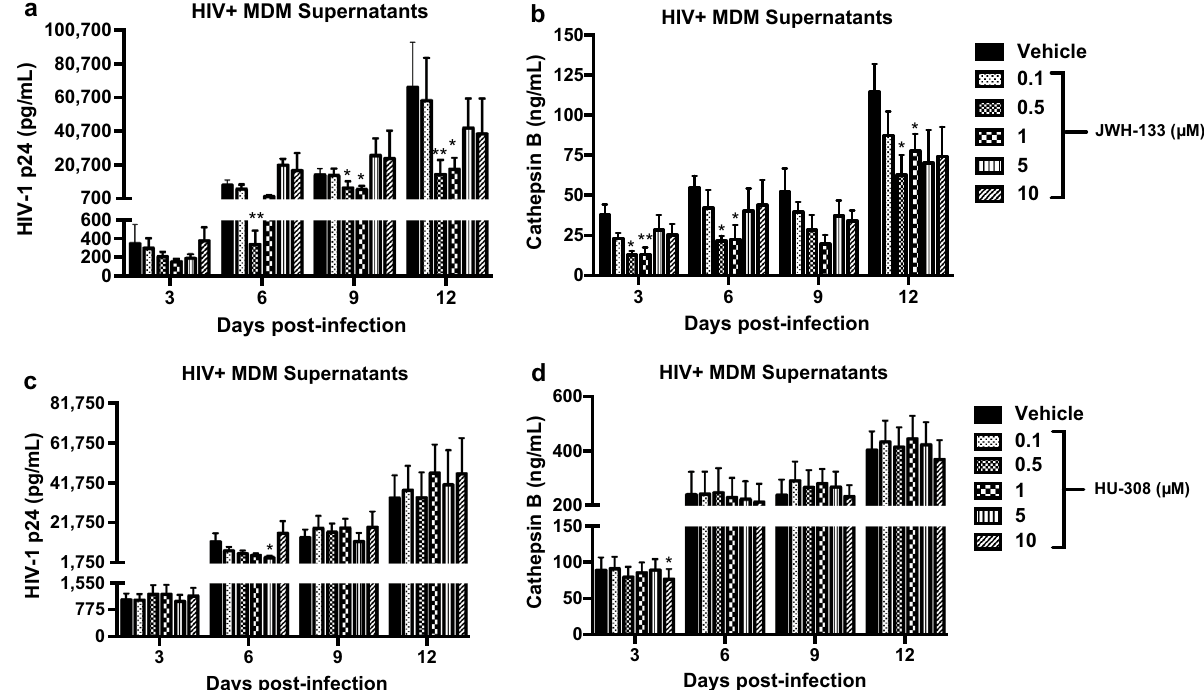
Figure 2. CB2R agonists treatment decrease HIV-1 replication and CATB secretion from MDM. MDM were infected with HIV-1 and treated with CB2R agonists, JWH-133 and HU-308. HIV-1 p24 and CATB levels were measured from supernatants of days 3, 6, 9, and 12pi by ELISA. ( a ) Temporal HIV-1 p24 levels in supernatants of HIV-infected MDM treated with JWH-133. ( b ) Temporal CATB secretion levels in supernatants of HIV- infected MDM treated with JWH-133. Figures a and b are representative of at least four different donors (n = at least 4). ( c ) Temporal HIV-1 p24 levels in supernatants of HIV-infected MDM treated with HU-308. ( d ) Temporal CATB secretion levels in supernatants of HIV-infected MDM treated with HU-308. Figures c and d are representative of at least six different donors (n = at least 6). Graphs are presented using the mean and the ± standard error of the mean (SEM). * p < 0.05, ** p < 0.01 vs. vehicle control at its respective